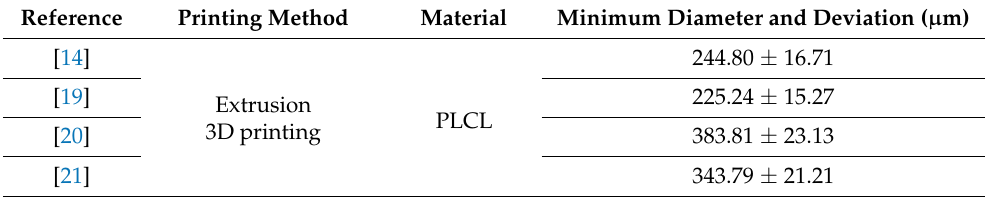
Table 1. Results of printed PLCL filaments in recent